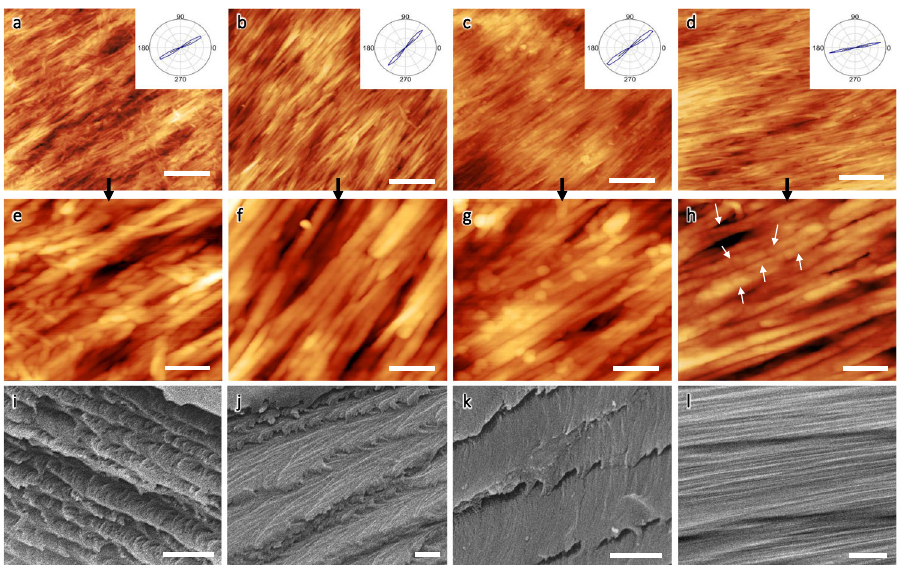
Fig. 2 | Microstructure transform from chiral nematic to uniaxial nematic organization under magnetic fi eld. AFM topographical images at different mag- ni fi cations for a , e bCNC fi lms, b , f bCNC_MNP1, c , g bCNC_MNP2, and d , h bCNC_MNP3 fi lms. Images were collected near the edge of magnet. Scale bars